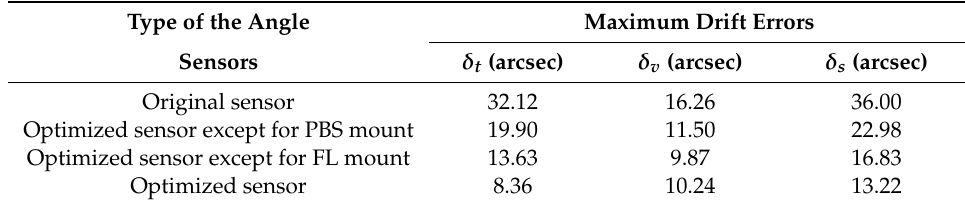
Table 3. Maximum drift errors of the angle sensors for pitch. Type of the